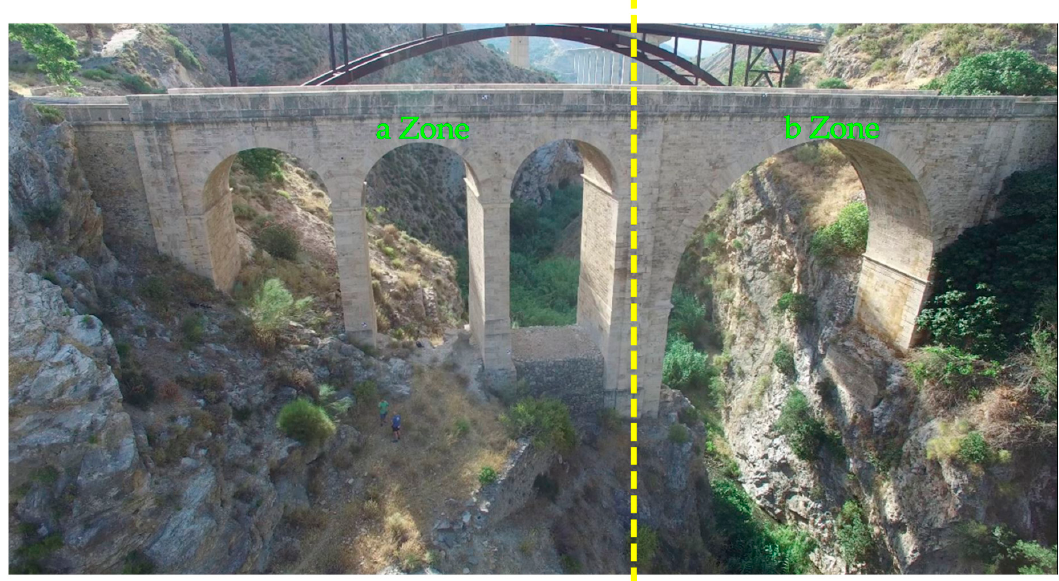
Figure 4. Ízbor bridge image taken by remotely a piloted aircraft system (RPAS) .